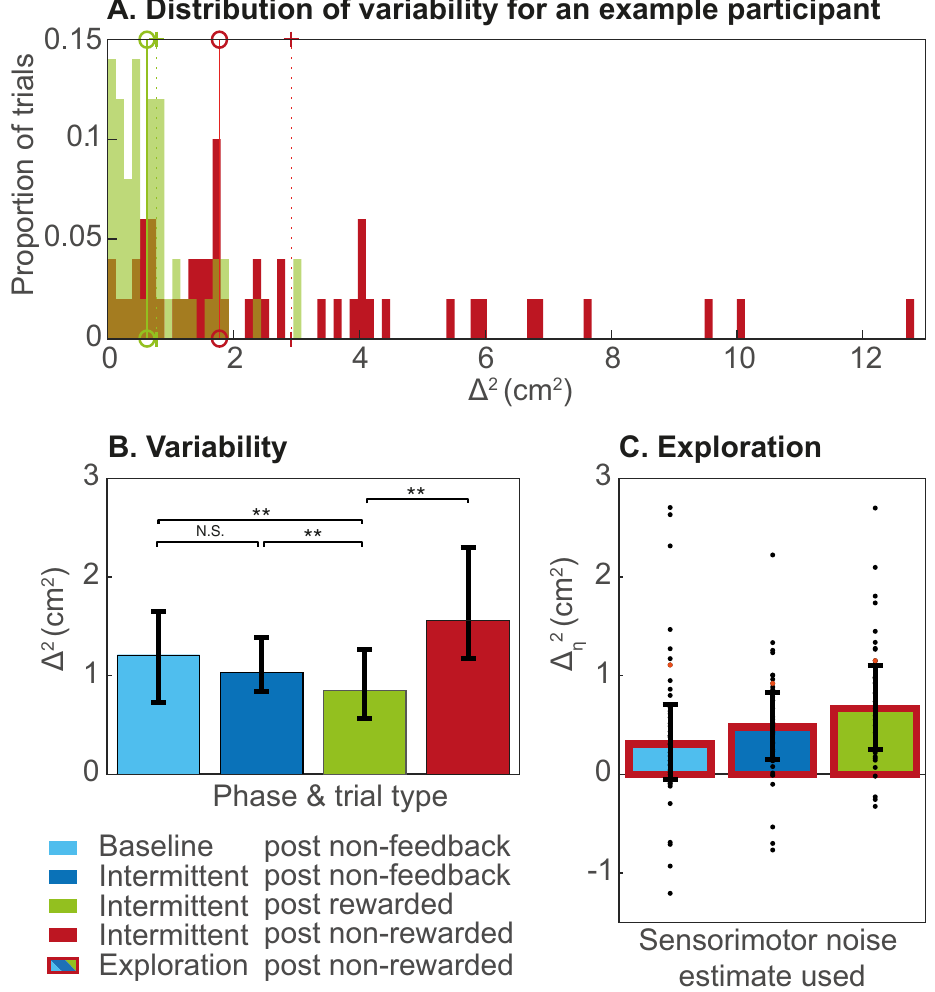
Fig 2. Variability and exploration. The color of the bar indicates which trials are used to estimate variability. (A) Distribution of squared trial-to-trial changes following rewarded (green) and non-rewarded (red) trials for an example participant. Vertical lines indicate the median (solid) and mean (dotted) of the distribution. (B) Variability ( Δ 2 ) on all trial types. Bars indicate the median across participants and error bars the interquartile range. Double stars indicate significant differences at p < 0.01. (C) Exploration ( Δ η 2 ) following non-rewarded trials, calculated based on Eq 1 plotted in the same format as panel A. Bars indicate the median across participants and error bars the interquartile range. Dots indicate the data of individual participants; the red dot indicates the example participant of panel